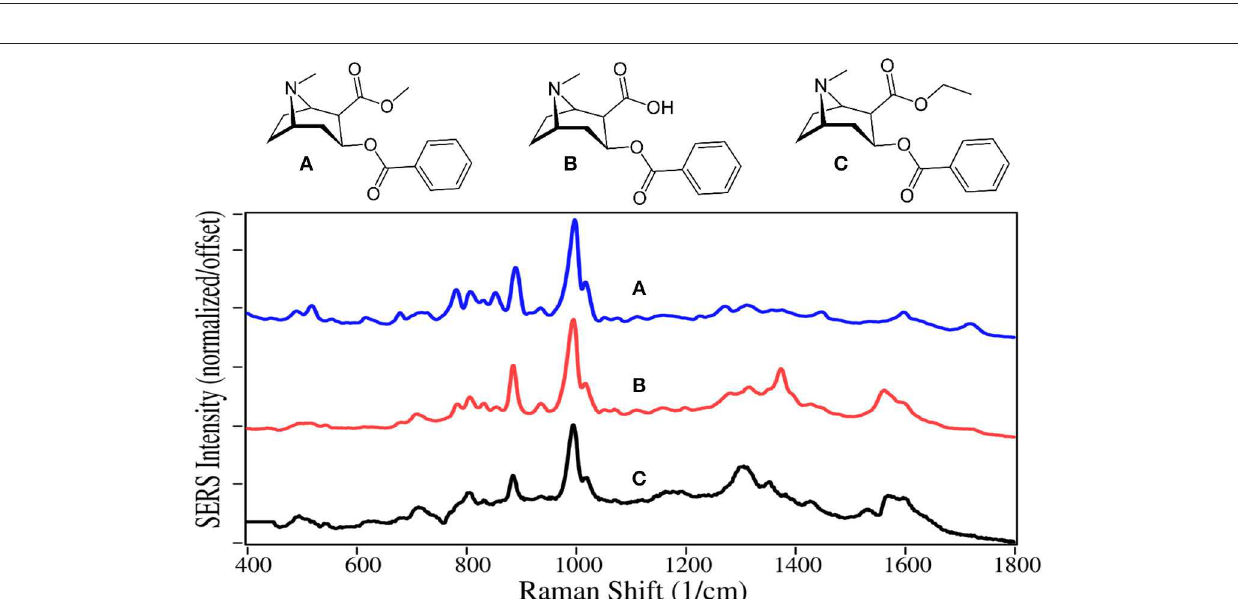
FIGURE 7 | Structures and 100 ppm SERS of (A) cocaine, (B) benzoylecgonine, and (C)